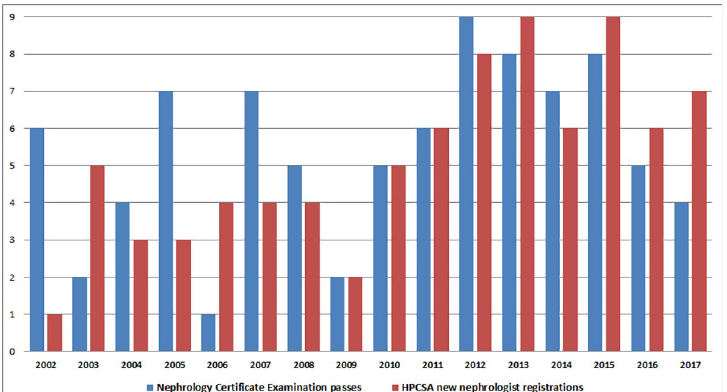
Fig 2. Annual number of trainees passing the colleges of medicine of South Africa certificate in nephrology examination and number of new HPCSA nephrologist registrations. Abbreviation: HPCSA, Health Professions Council of South